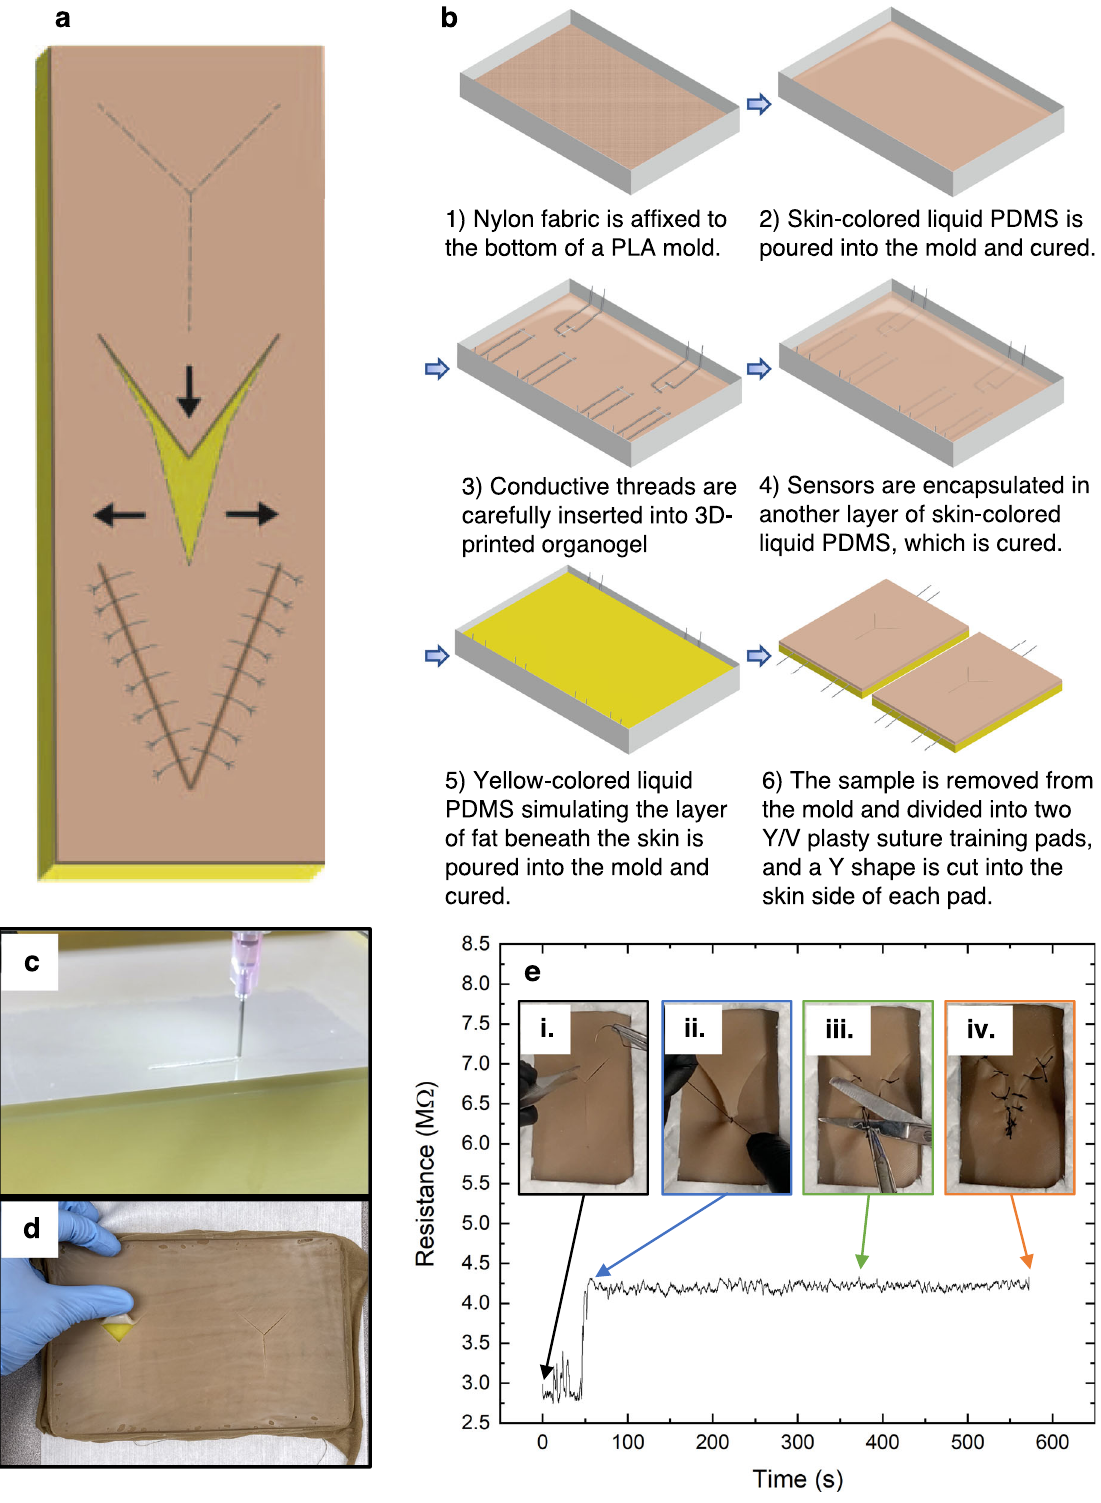
Fig. 1 Fabrication and demonstration of a sensorized Y/V plasty tissue model. In a Y/V plasty, a Y-shaped incision with the vertex located at the site of unwanted tissue is cut into the dermal layer, and the fl ap in the skin layer is pulled down and sutured into a V shape after excision ( a ). A sensorized Y/V plasty tissue suturing pad ( b ) is fabricated by encapsulating a conductive organogel and conductive thread electrodes within the skin layer of the pad. This organogel is 3D-printable ( c ) and visually imperceptible in the skin layer of the pad ( d ). The strain sensor located in the skin fl ap demonstrated a clear response to the elongation experienced by the fl ap during suturing ( e